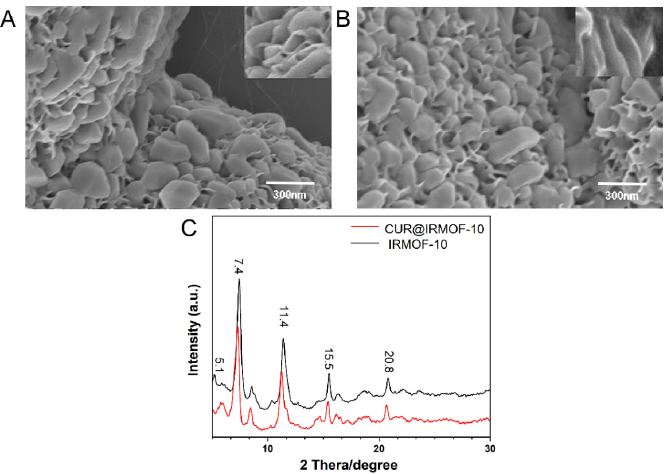
Figure 3. Characteristics of IRMOF-10 and CUR@IRMOF-10: ( A ) SEM image of IRMOF-10; ( B ) SEM image of CUR@IRMOF-10; ( C ) X-ray diffraction (XRD) analysis of IRMOF-10 .